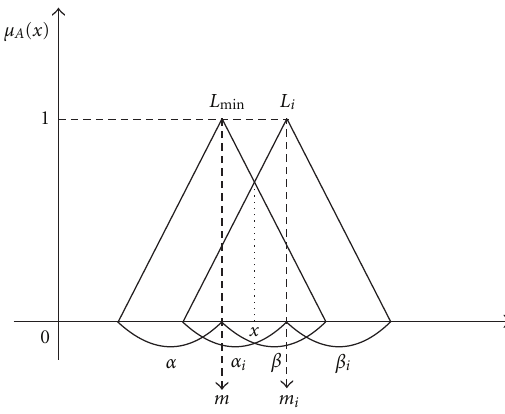
Figure 3: Triangular LR acceptability index.